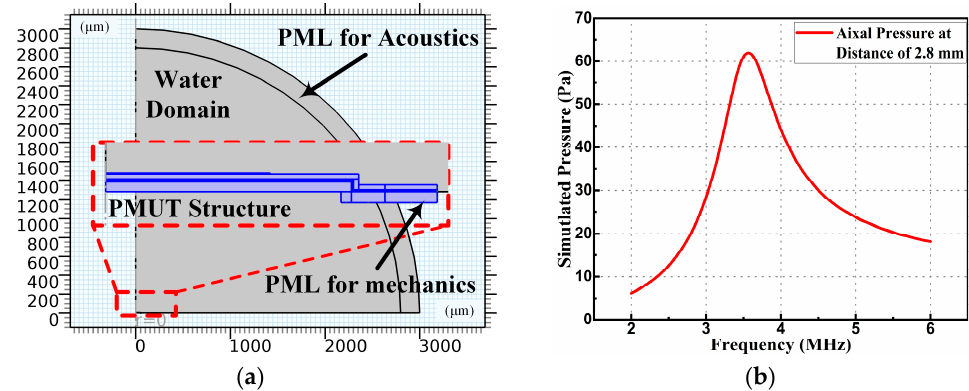
Figure 3. ( a ) Two − dimensional model of a PMUT with a perfect matching layer (PML) in COMOSL. ( b ) Frequency response of absolute acoustic pressure on the axial direction with the distance of 2.8 mm for one PMUT unit in water medium.